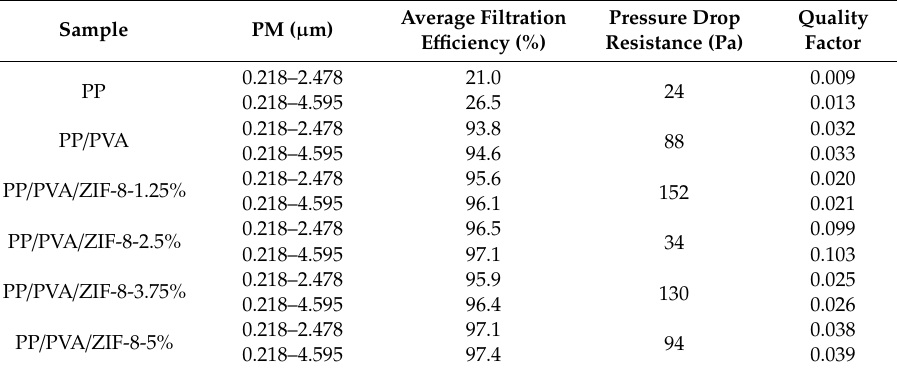
Table 5. Average filtration e ffi ciency, pressure drop resistance, and quality factor of PP melt-blown membranes and PP / PVA / ZIF-8 melt-blown electrospun composite membranes.